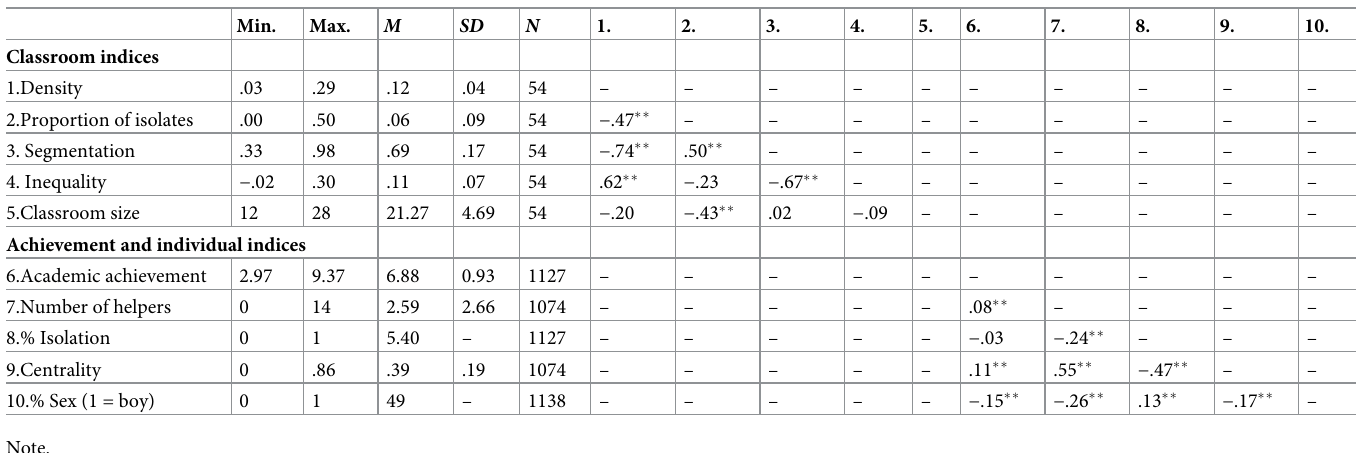
Table 1. Descriptives of and bivariate correlations between the study variables.